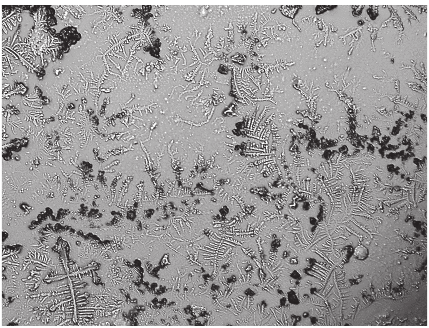
Figure 2: TF pattern obtained from a dry eye